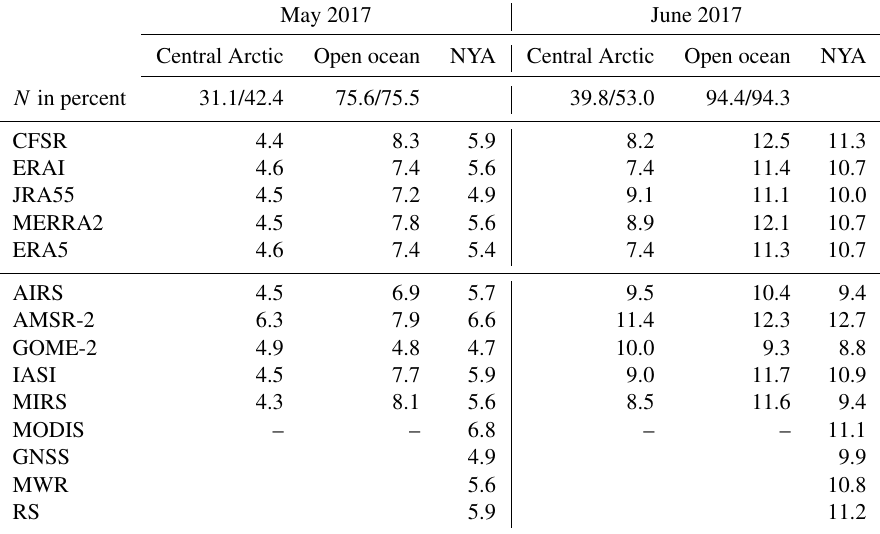
Table 3. Monthly mean IWV (in kgm − 2 ) for May and June 2017 derived for the areal averages of the central Arctic and open ocean. The mean has only been calculated from those grid points which have valid entries for all products. N denotes the percentage of valid grid points in terms of their number and taking the area fraction into account. For Ny-Ålesund (NYA) the closest grid point is